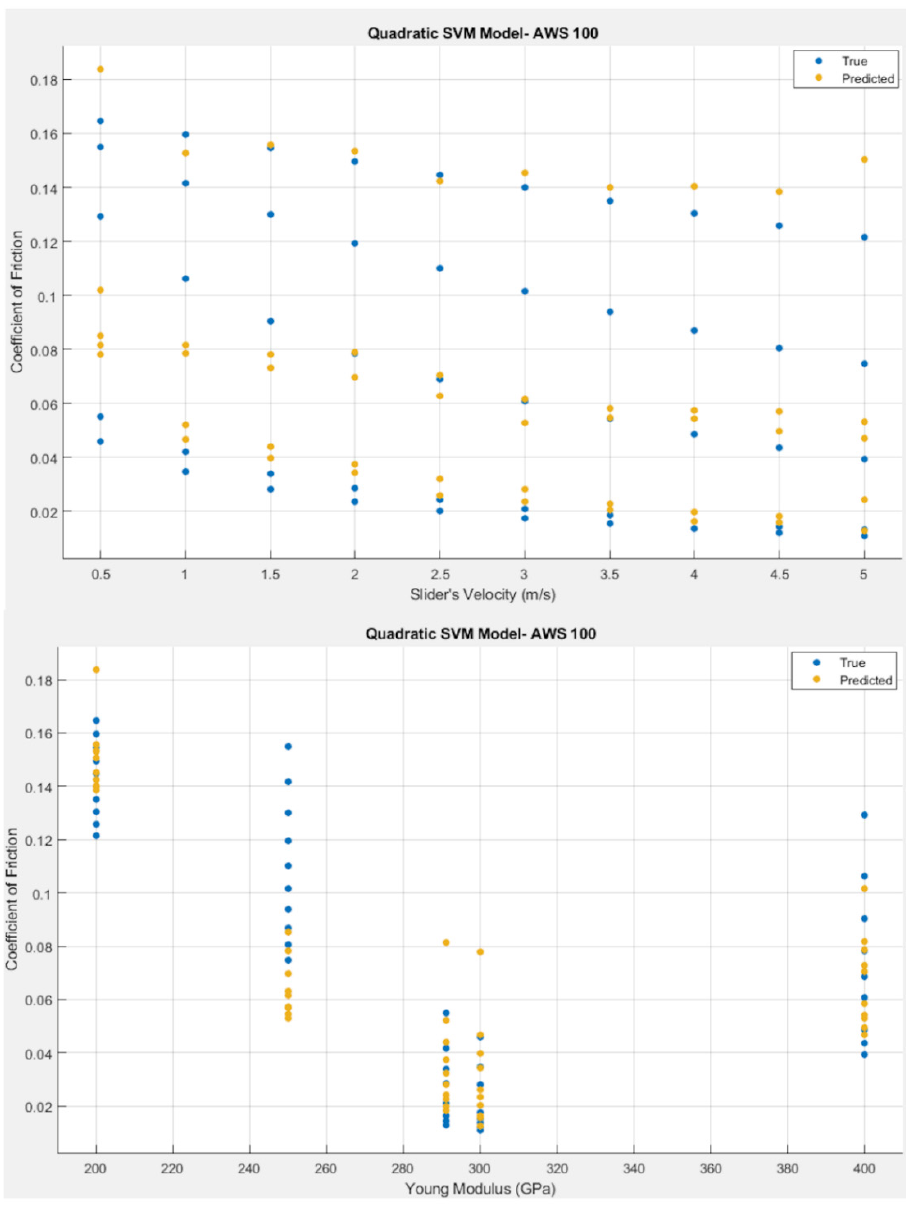
Figure 9. Quadratic SVM model results for the case of AWS